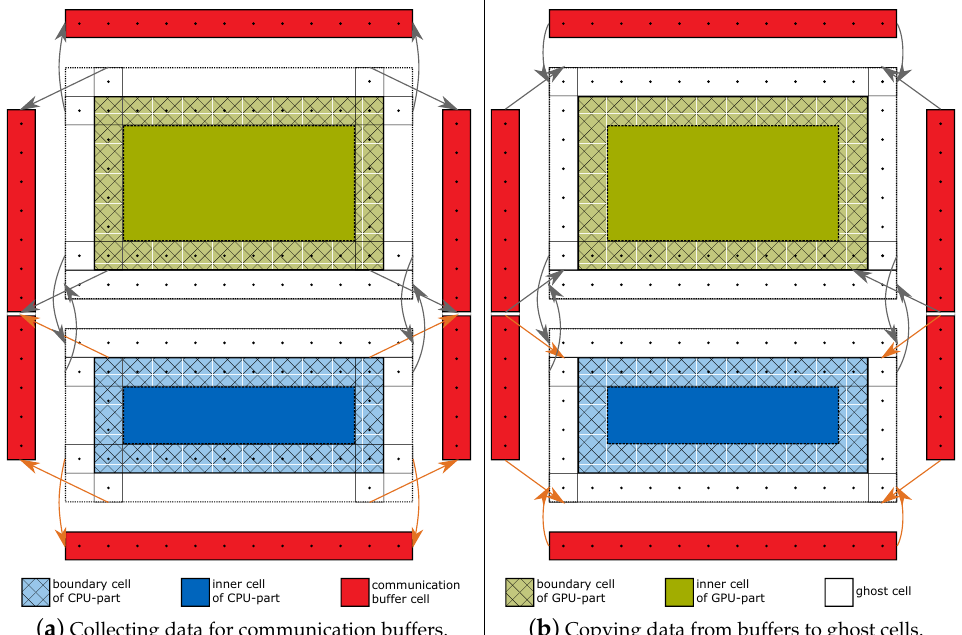
Figure 5. α -step collection ( a ) and distribution ( b ) of data. The behavior of one MPI process with four communication partners is illustrated in 2D. GPU- and CPU-part of the subdomain are colored in green and blue. Boundary cells are hatched and colored in light-green and light-blue, ghost cells are colored in white. Memory for the communication buffers is colored in red. Gray arrows indicate copy direction between and location of host and device. Analogously, orange arrows express in-host memory copy operations. Lattice cells affected by read/write operations are marked with a